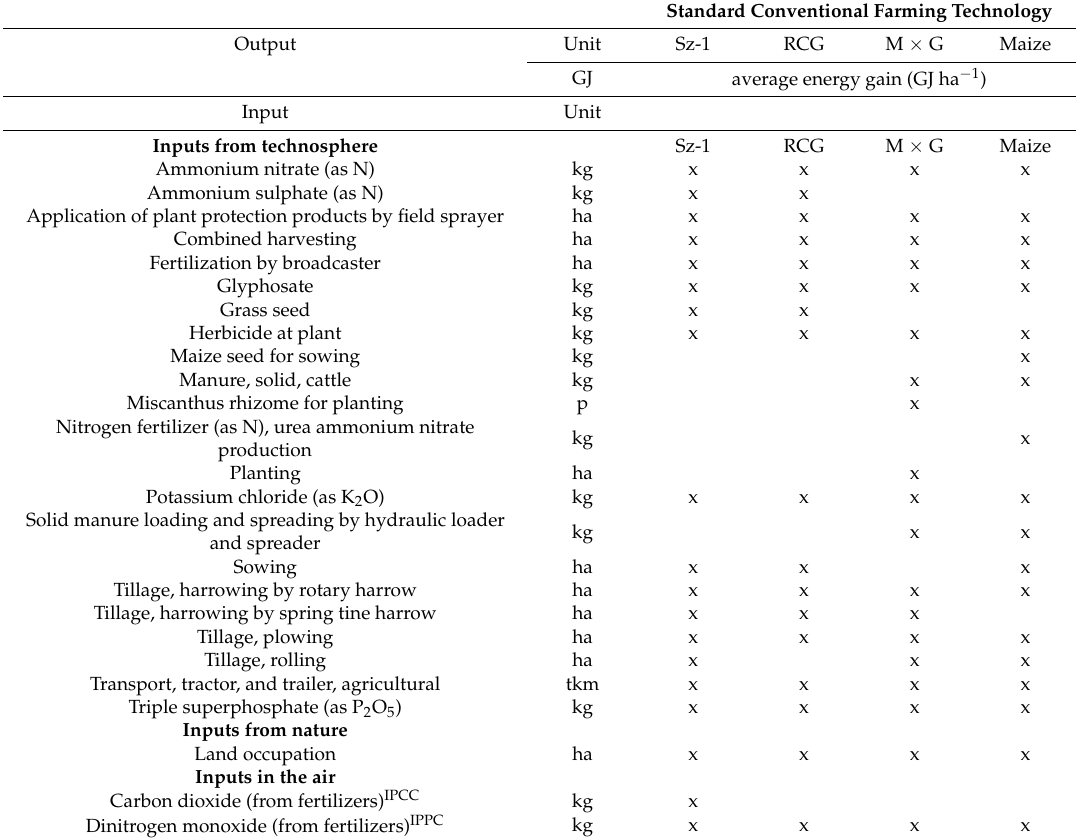
Table 8. Inventory table: inputs and outputs of life